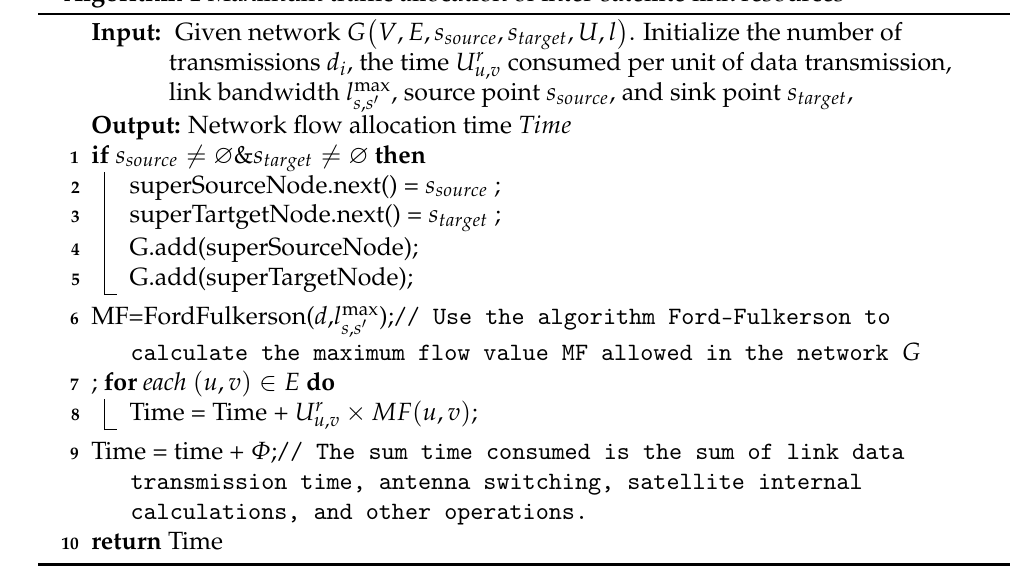
Algorithm 1 Maximum traffic allocation of inter-satellite link